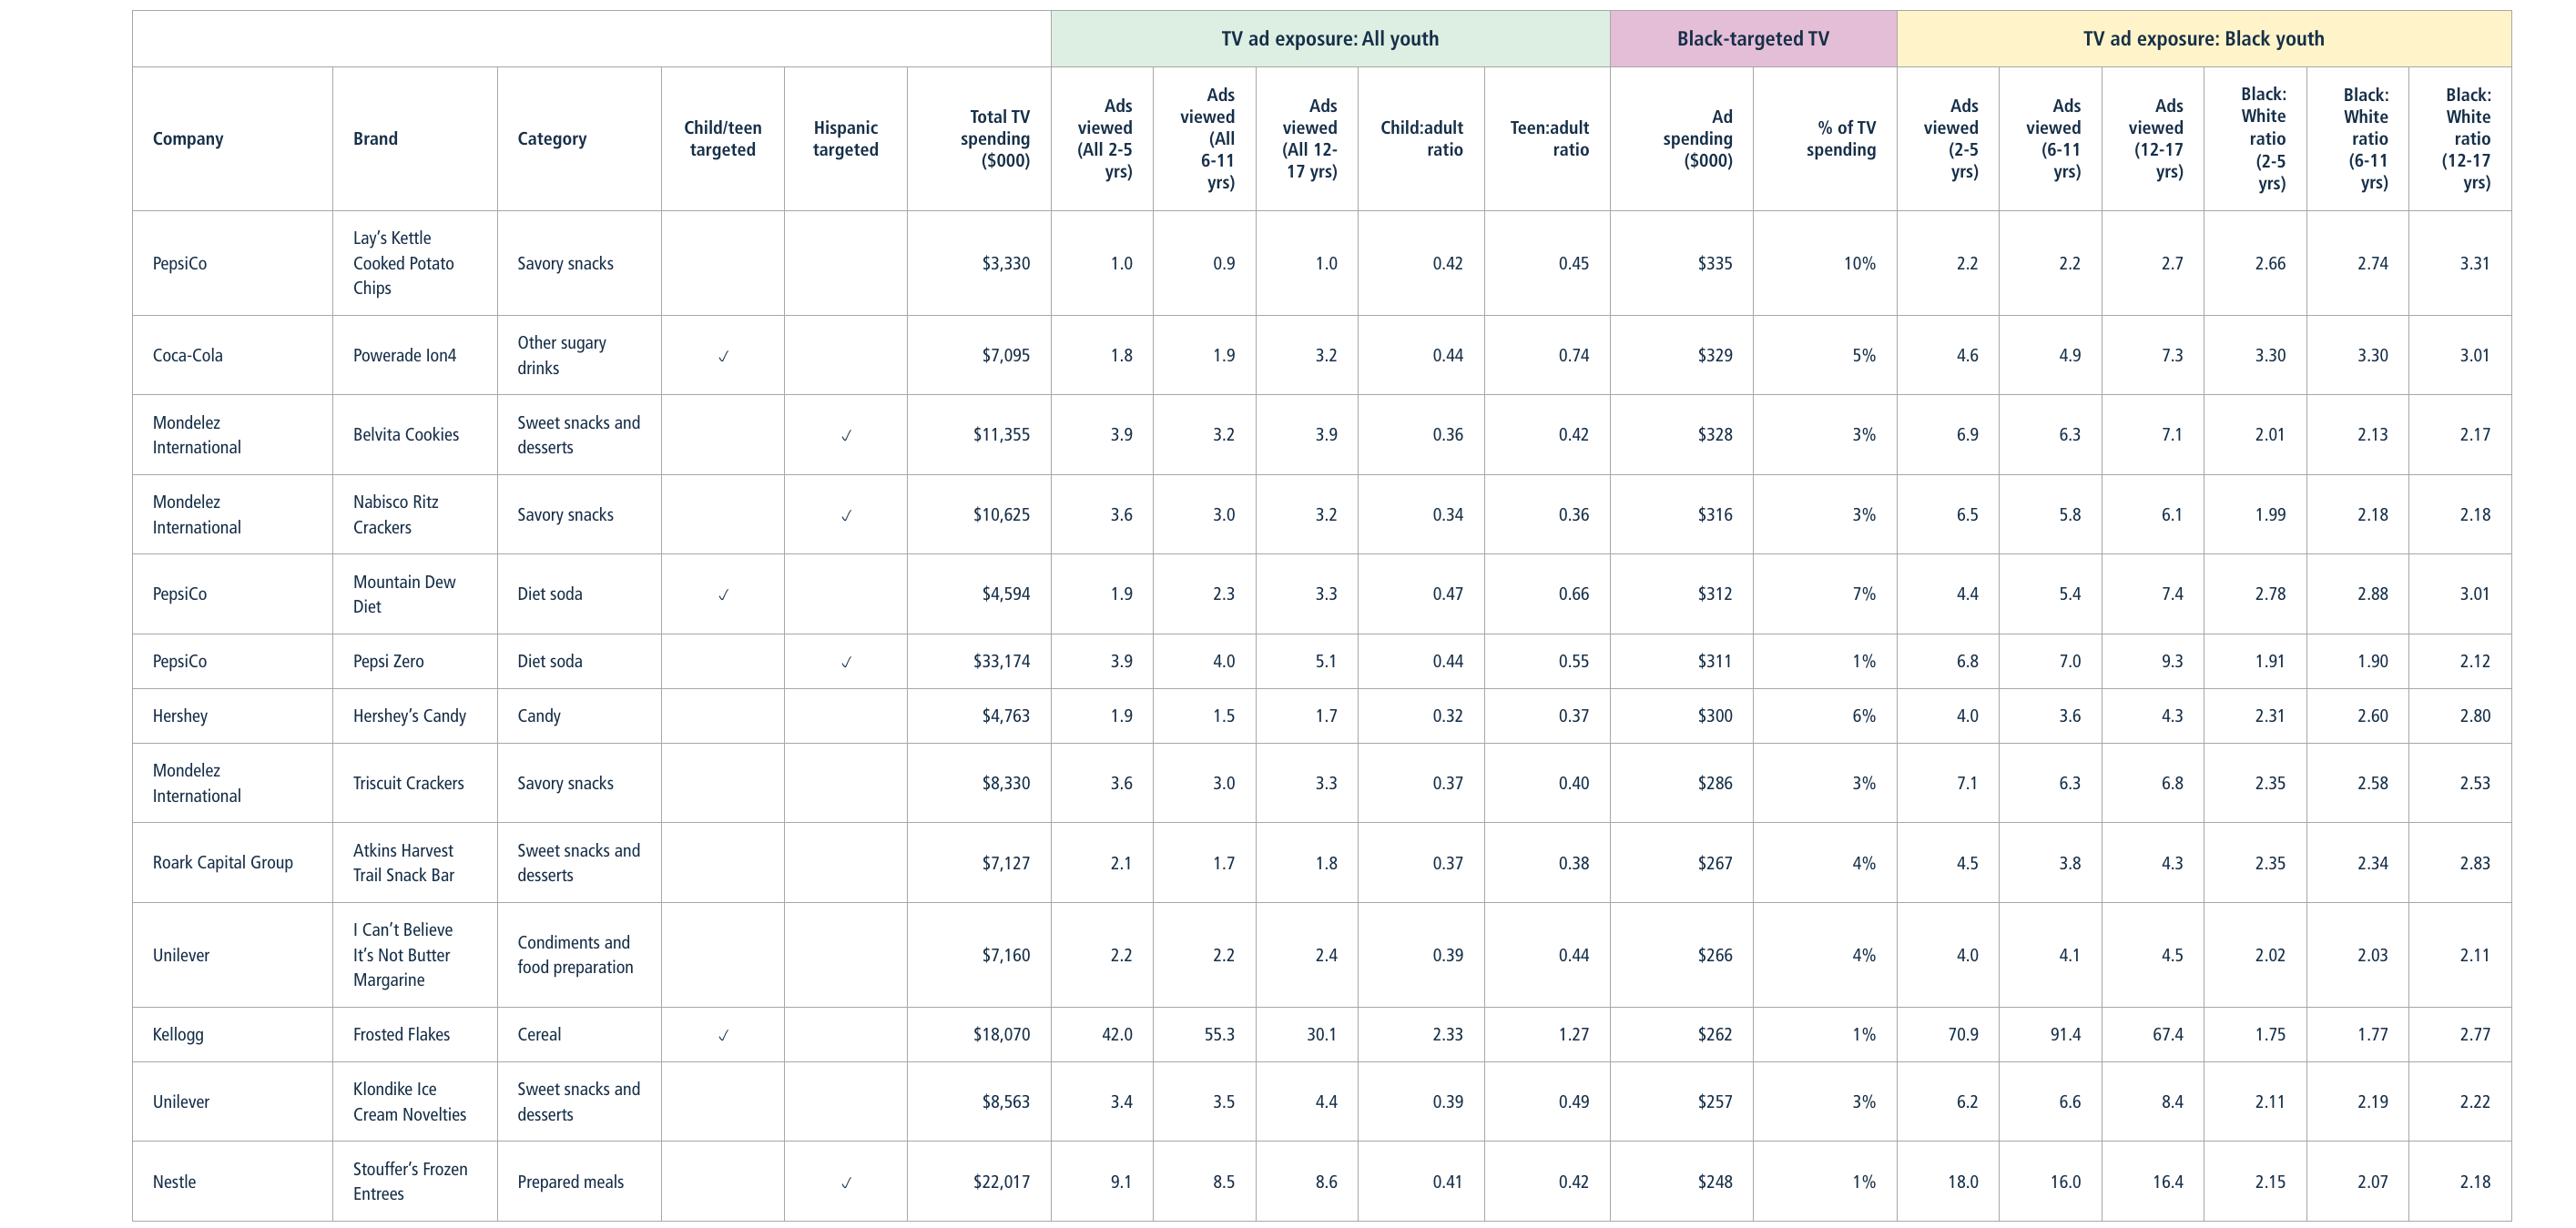
TABLE 3. BRANDS TARGETED TO BLACK CONSUMERS